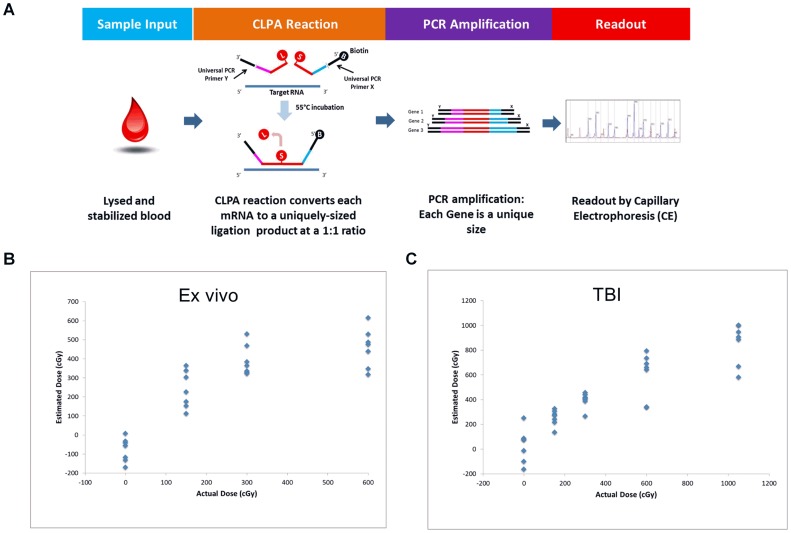
The CLPA assay predicts the radiation status of human PB samples with high accuracy.A) A schematic representation of the CLPA assay is shown. B) Scatter plots are shown of the predicted radiation dose levels of human PB samples (y axis) which were irradiated ex vivo with the radiation dose levels shown on the x axis. C) Scatter plots are shown of the predicted radiation dose levels of PB samples from human TBI patients (y axis) who were irradiated with the dose levels shown on the x axis. n = 7 patient samples in each group.